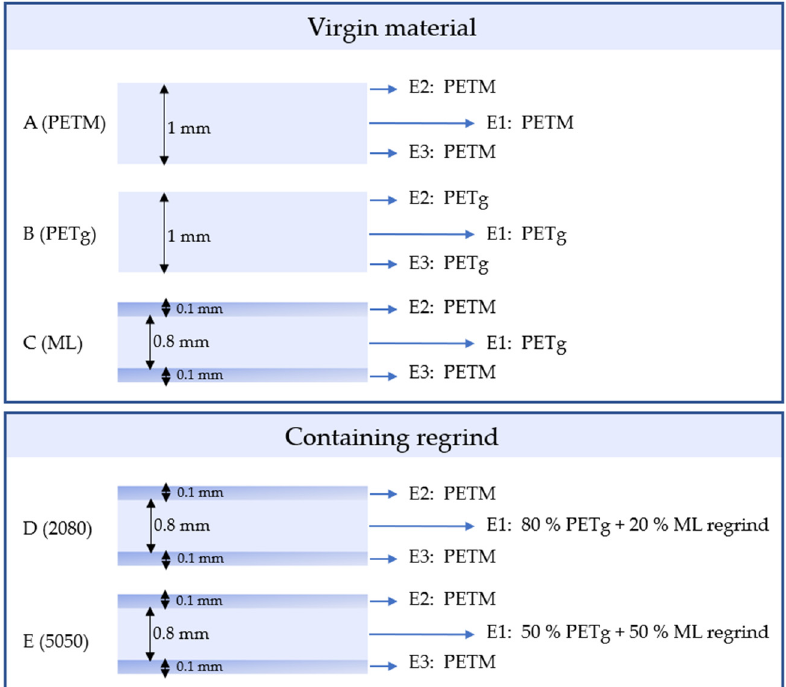
Figure 1. Composition of the produced multilayer sheets in this work, with a relative layer thickness distribution of 10/80/10. ( A , B ): pure sheets (PETM, PETg), ( C ): multilayer (ML), ( D , E ): the multilayer containing 20% regrind (2080) and 50% (5050) regrind in the middle layer.